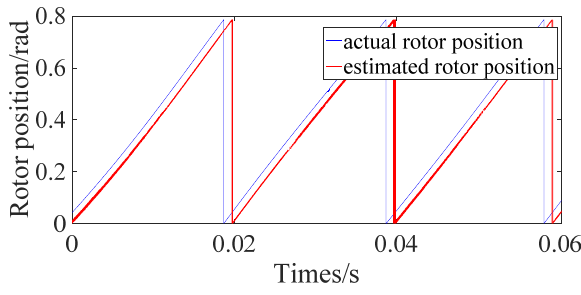
Figure 6. Motor rotor position.